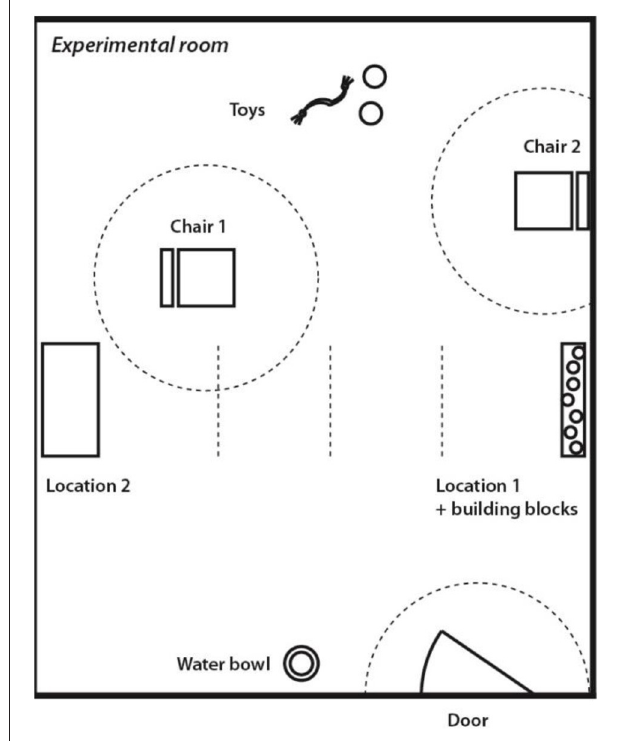
FIGURE 1 | Set-up used in the “Strange Situation